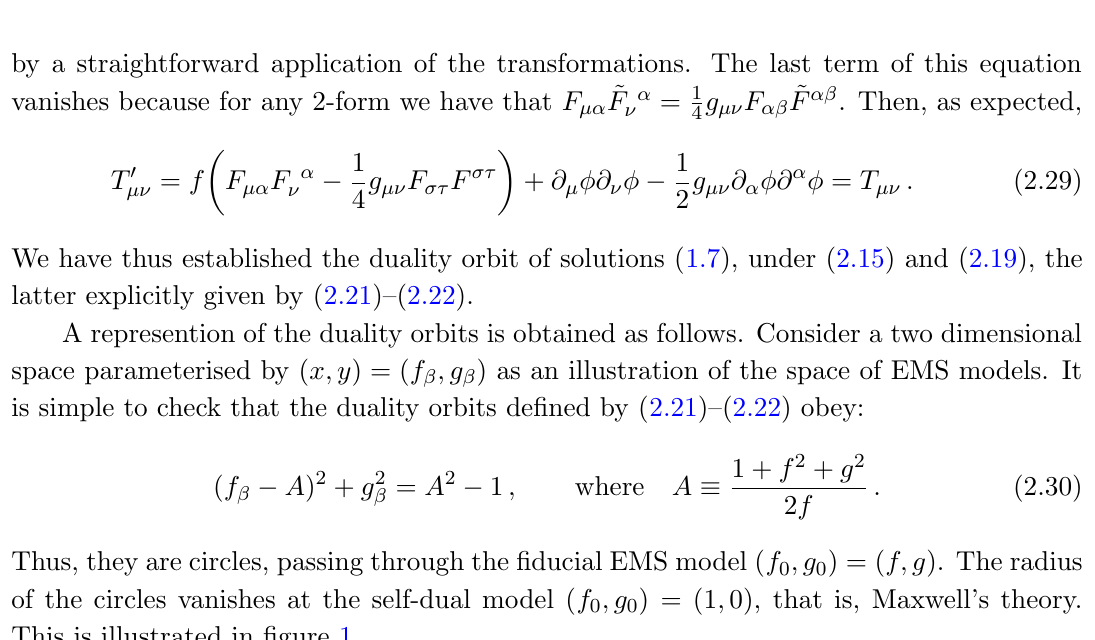
Figure 1 . Duality orbits in the space of EMS models, for di(cid:11)erent values of the (cid:12)ducial EMS model ( f; g ). The self-dual model, Maxwell’s theory, is the black dot at (1 ;